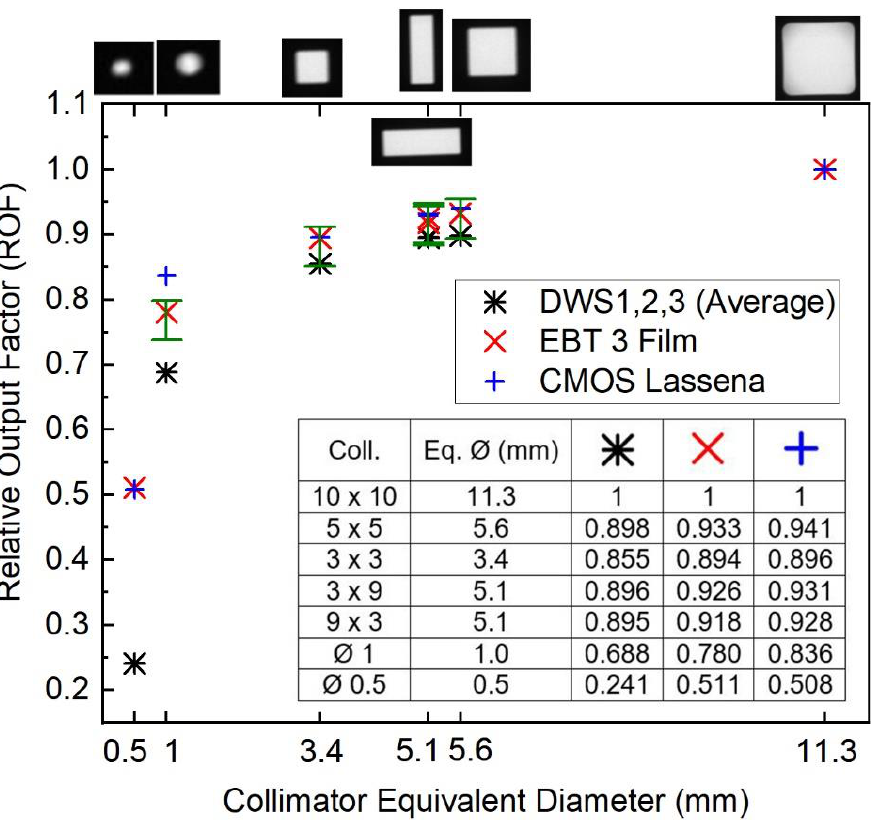
Figure 6. ROF for SARRP brass collimators. Detectors’ EPOM positioned at 2 cm depth, at the isocentre, 3 cm backscatter, and 33 cm SSD. Error bars represents a fixed standard deviation of ± 3% for ROF, on the average over the three different detectors. Representative images of the different field shapes and sizes (shown on the upper horizontal axis) were acquired with the CMOS Lassena detector and are not at scale.